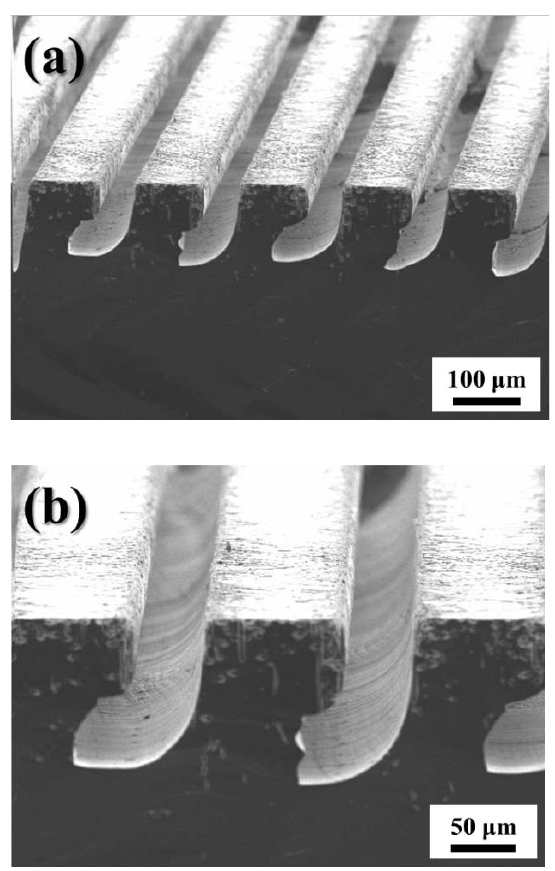
Figure 6. Curved Si groove arrays produced by magnetically guided MACE for 5 h using ( a ) a Swiss- / Fe / Au catalyst and ( b ) Au / Fe / Au catalyst (tilting angle: 90 ◦ cheese-like Au/Fe/Au catalyst and ( b ) Au / Fe encapsulated /Au catalyst (tilting angle: 90°). Swiss-cheese-like Au encapsulated